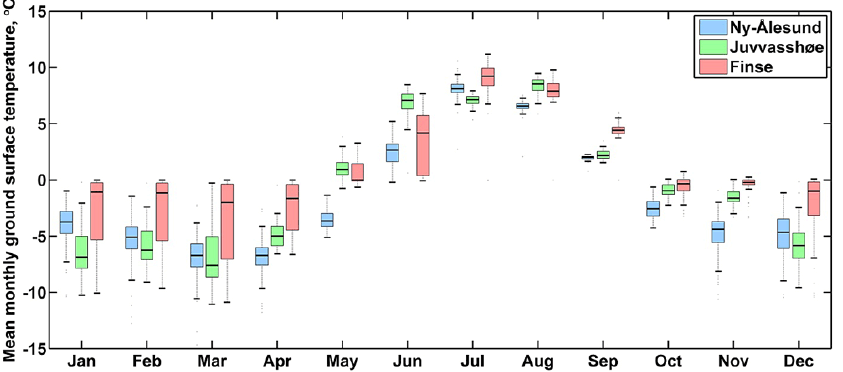
Figure 3. Variation of ground surface temperatures between the loggers at the three field sites. The bars indicate the 25th and 75th percentiles, while the whiskers indicate minimum and maximum values. The median is given as a horizontal line in each